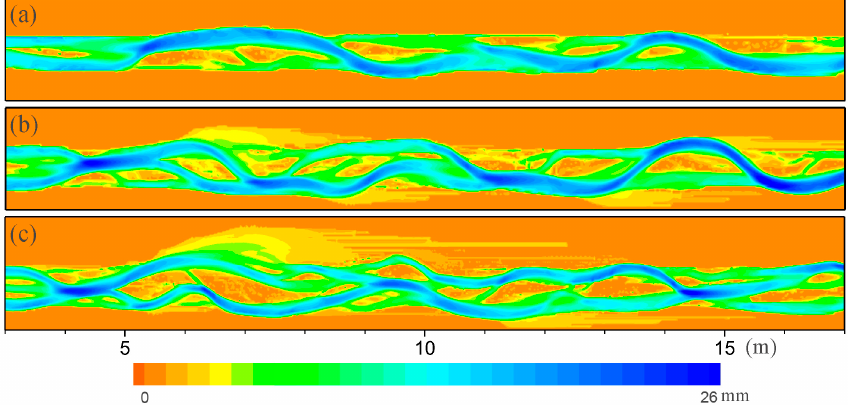
Figure 8. Braiding configurations at hour 27 with cell sizes of ( a ) 0.03 × 0.03 m 2 ; ( b ) 0.025 × 0.025 m 2 ; and ( c ) 0.02 × 0.02 m 2 .